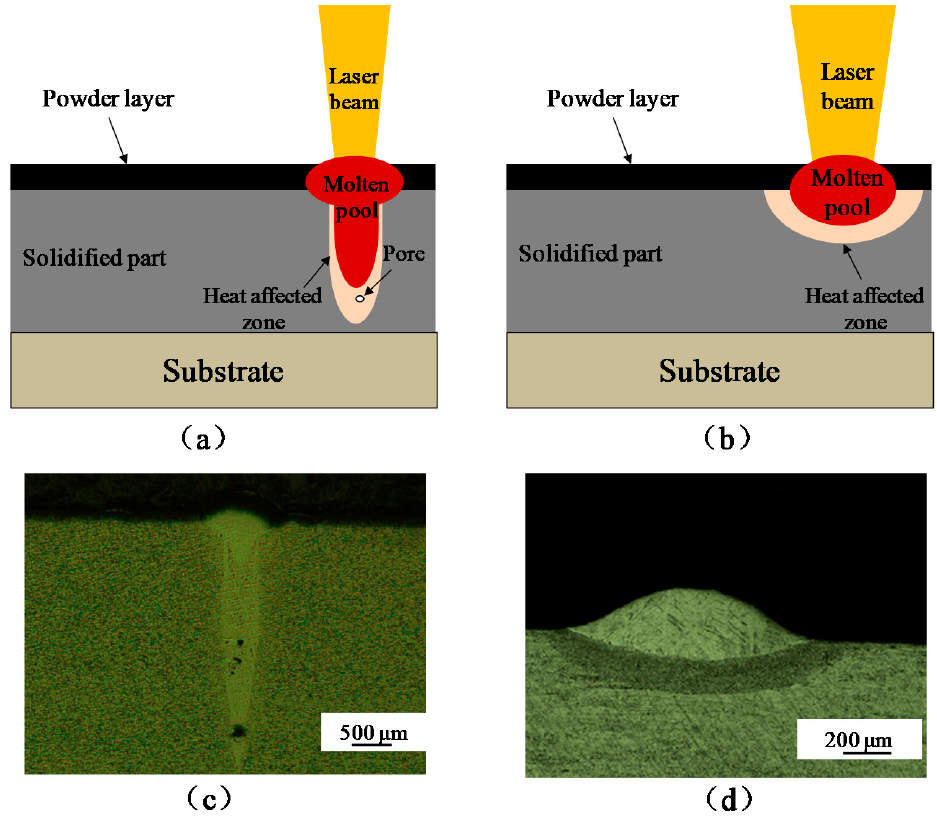
Figure 8. Schematic illustrations and optical micrographs of single-scan tracks formed using different laser beam diameters. Fabrication using a ( a , c ) 50-µm beam and ( b , d ) a 200-µm beam.